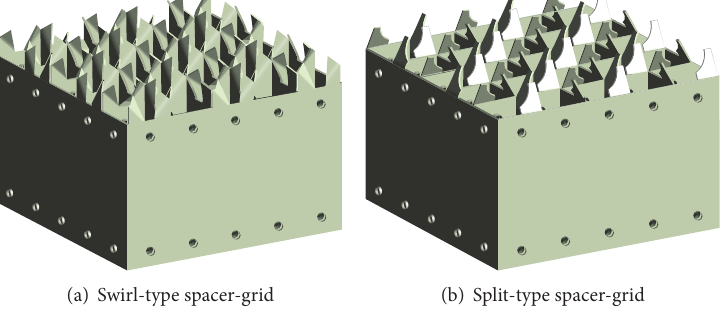
Figure 2: Types of spacer-grids tested in